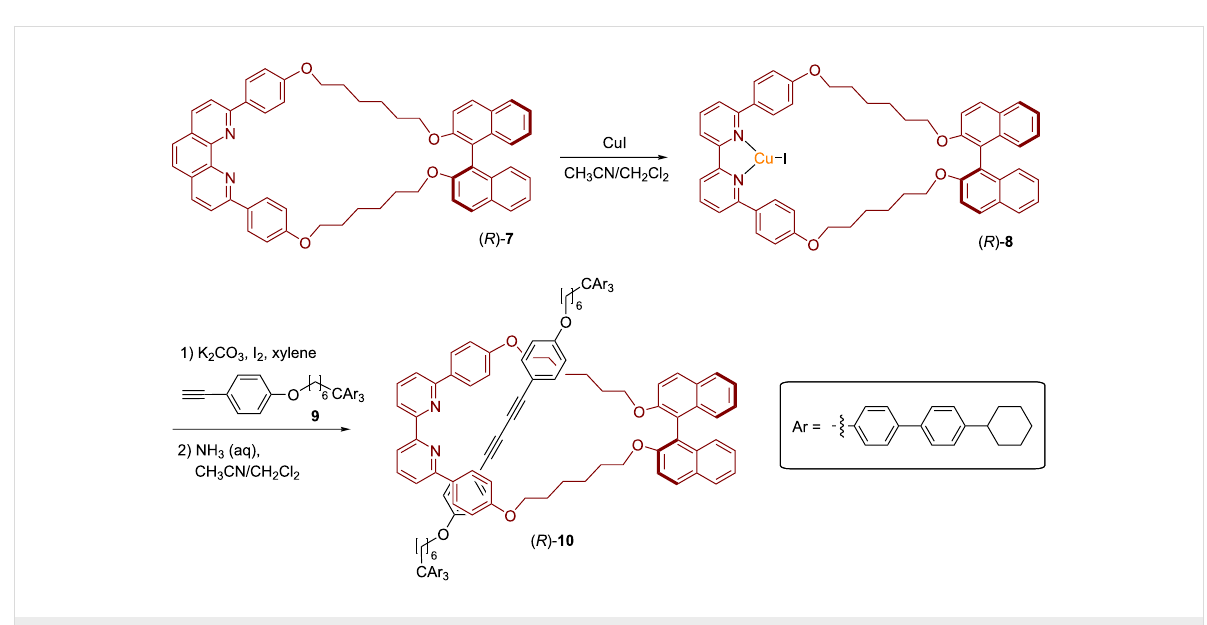
Figure 3: Synthesis of Saito´s [2]rotaxane ( R )- 10 from a BINOL-based macrocycle by the active metal template method.